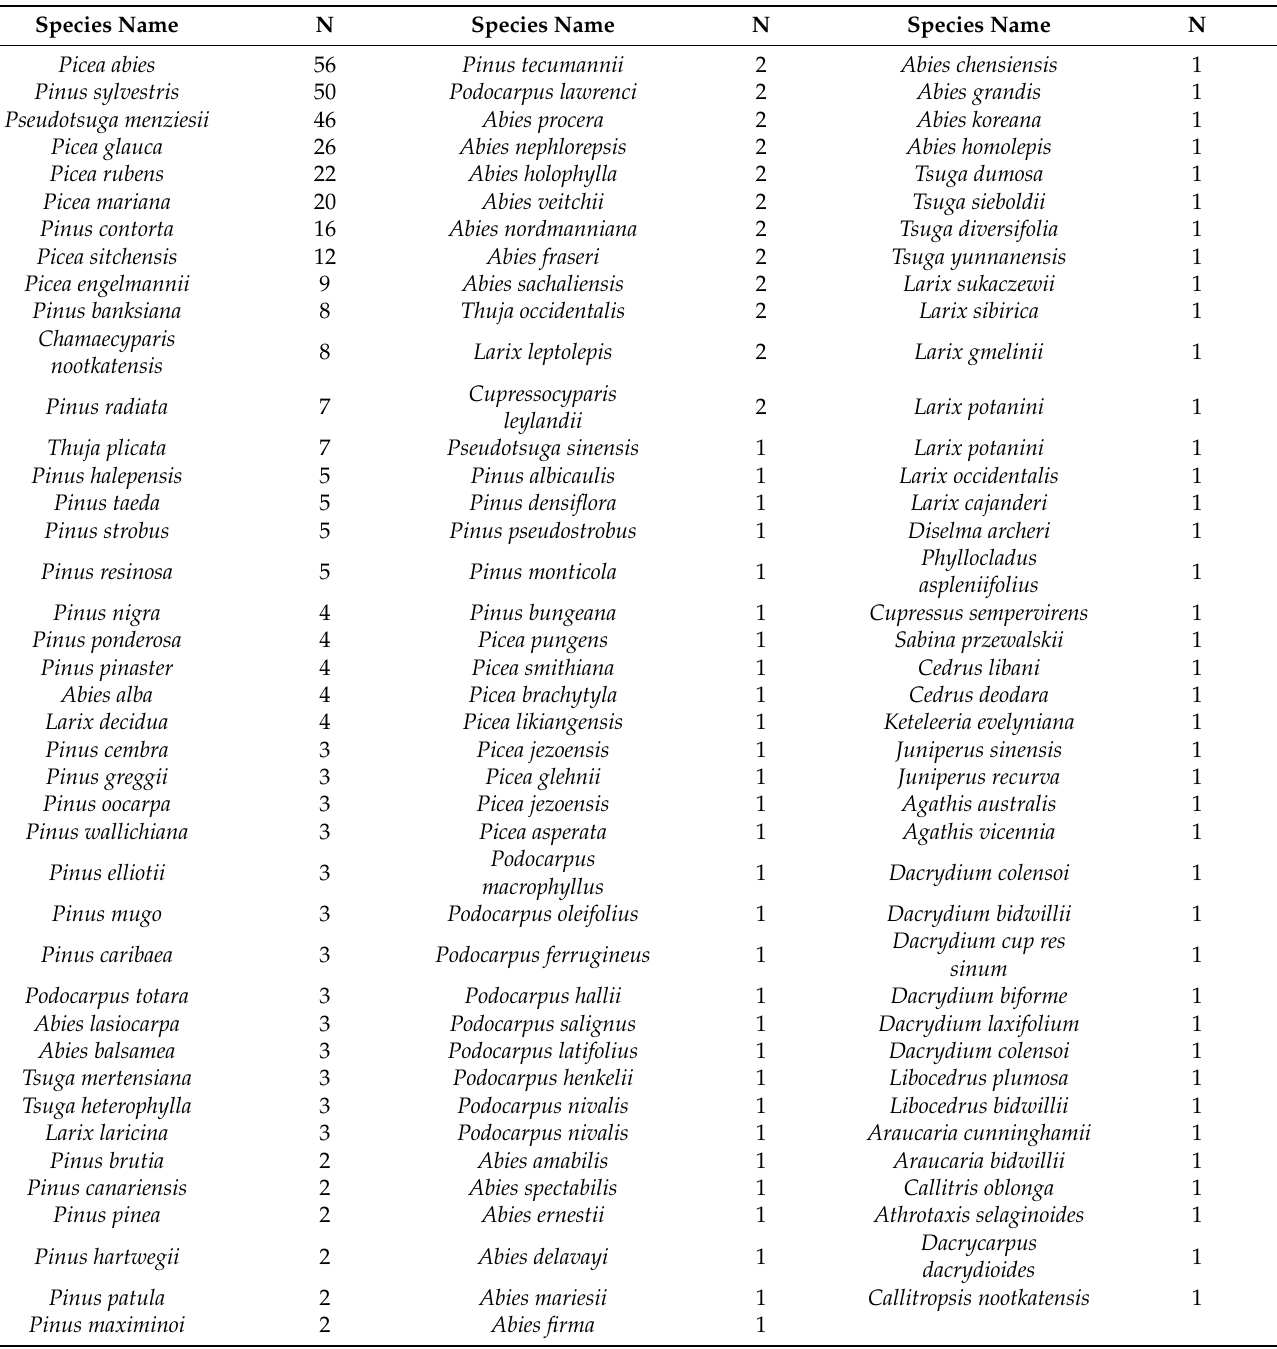
Table A2. Gymnosperm species included in this review and the number of studies which include